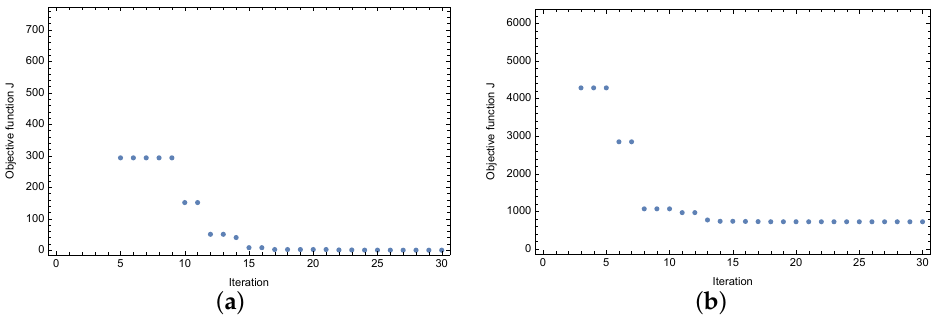
Figure 6. Values of the objective function in the case of 0% ( a ) and 2% ( b ) perturbation of the input data.